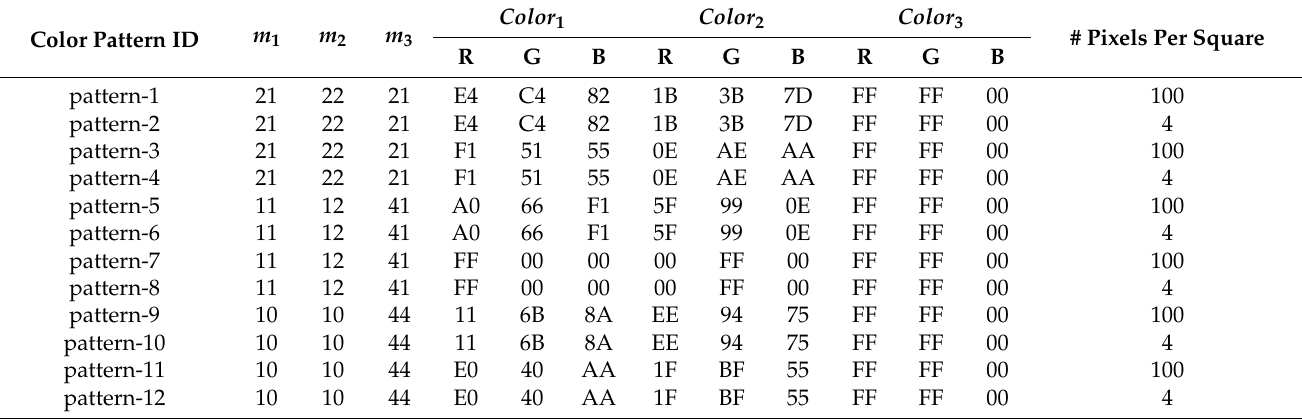
Table 4. Quantitative characteristics (specifications) of color